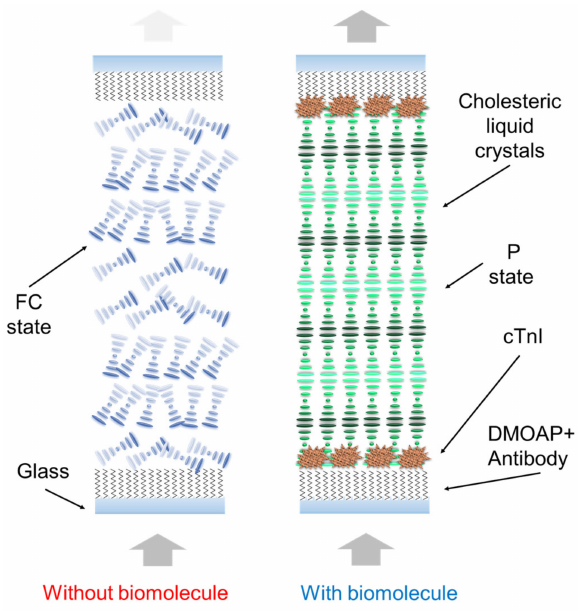
Figure 1. Schematic of the CLC test kit for rapid AMI testing. DMOAP enables CLC molecules to be vertically aligned. Schematic of the cTnI and peptide immunocomplex on the glass